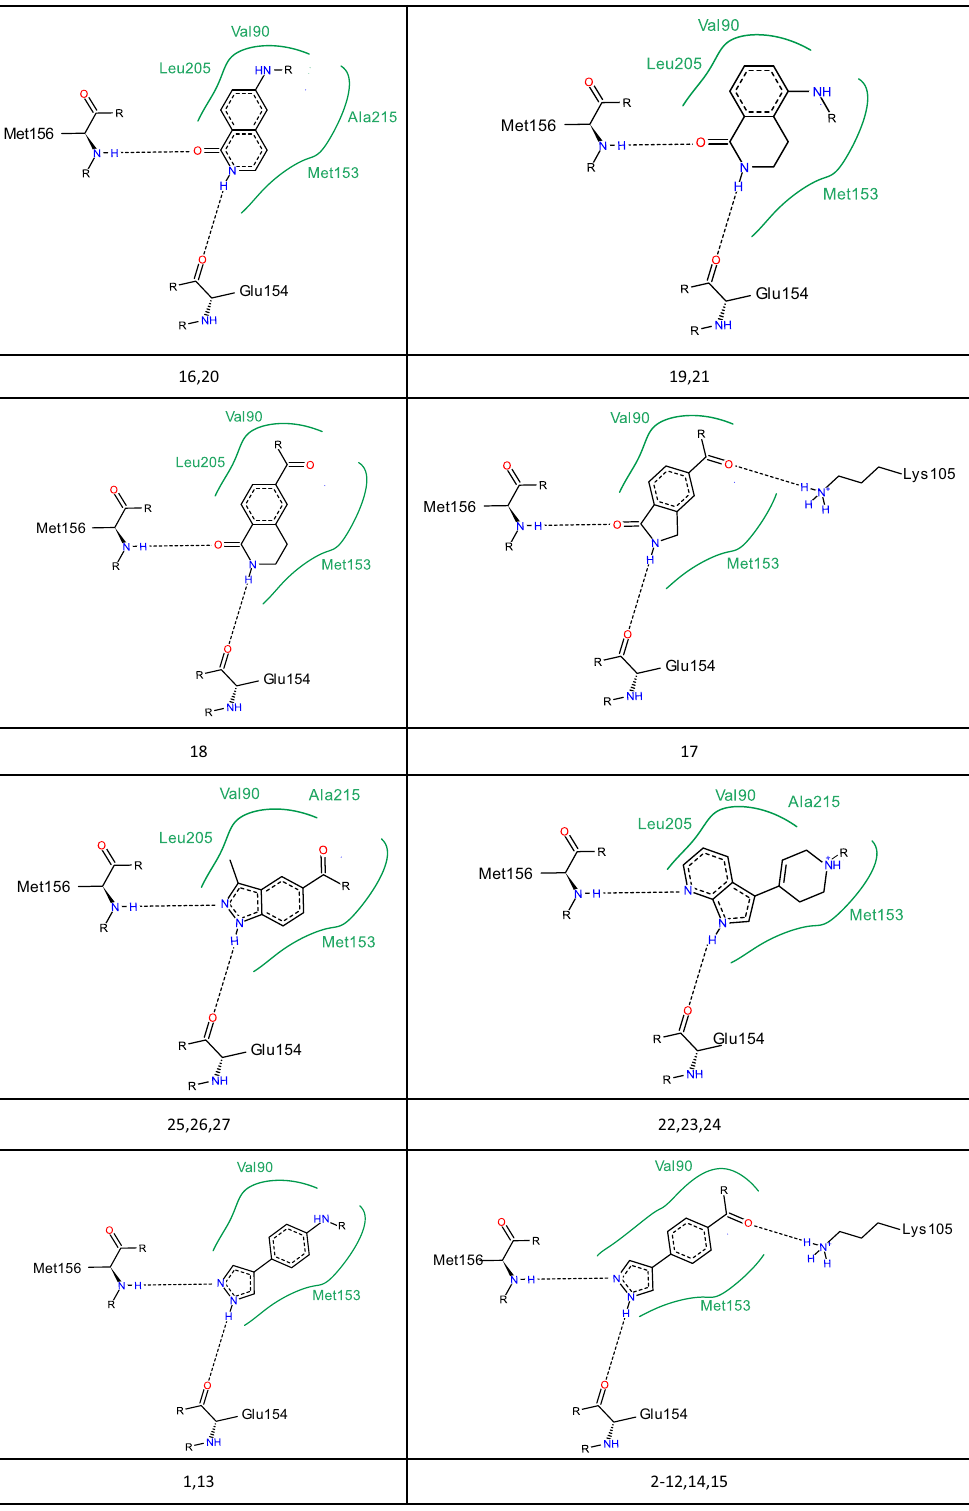
example is the list of active molecules in Supplementary Table 1 that were derived from the initial fragment